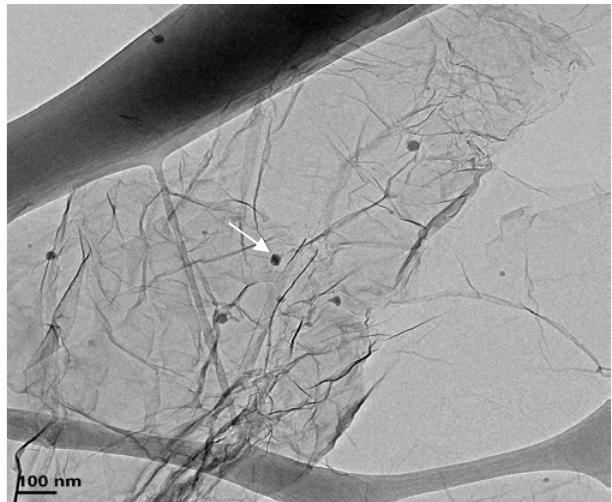
Figure 12. TEM micrograph of wear debris from lubrication with (IL + G) thick film lubricant (after sonication in ethanol and drying). Arrow points to wear debris.